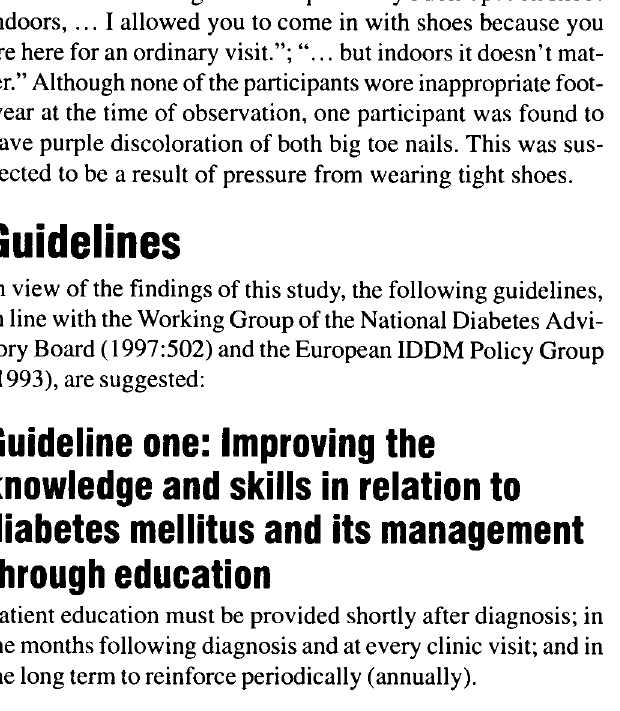
Table 1: Findings of direct observation of nail cutting by eight participants with diabetes in the rural areas of